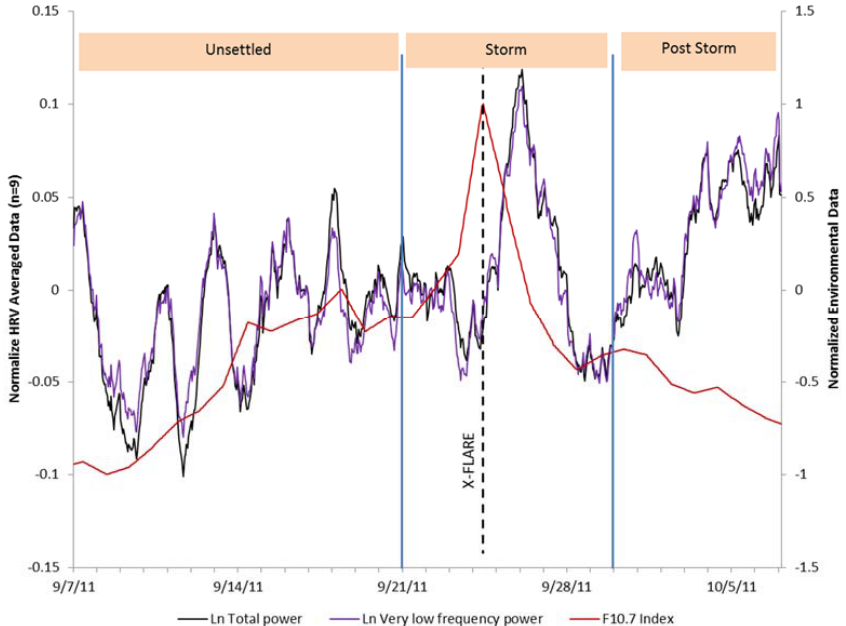
Figure 5. HRV total power and very low frequency power measures with the solar radio flux (F10.7) variations overlaid.